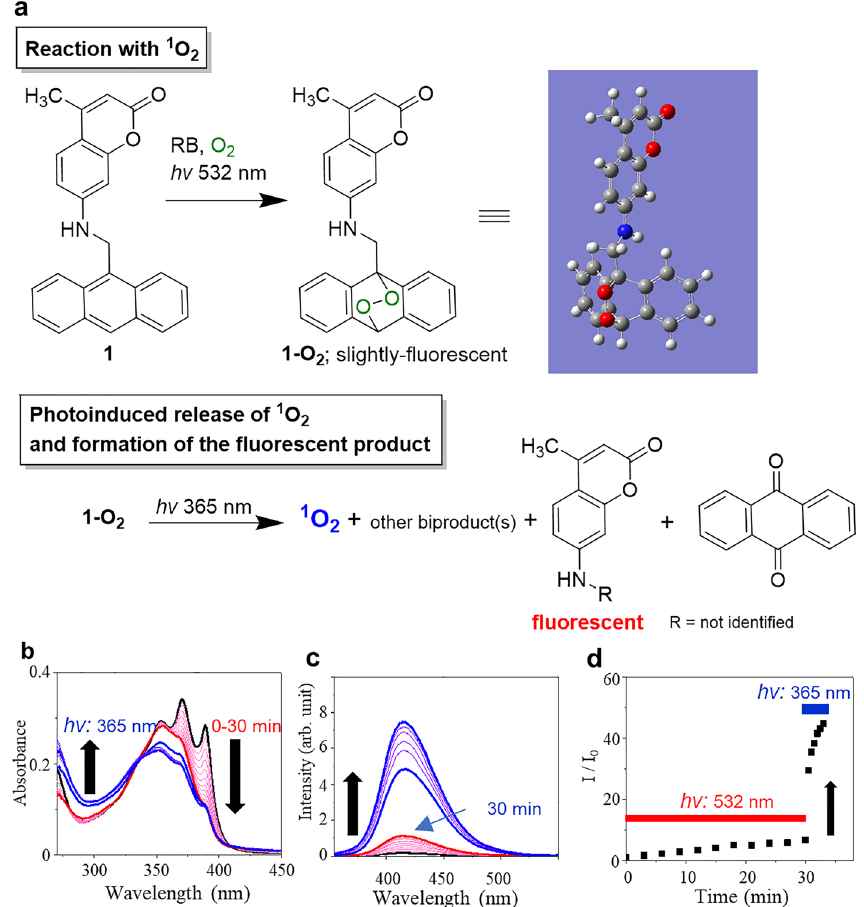
Figure 1. Trapping and photoinduced fluorogenic sensing and release of 1 O 2 . ( a ) Schemes of the two-step reactions of 1 and 1 O 2 . The 3D molecular image shows a DFT-optimized structure. ( b ) Absorption spectra of a solution containing 1 (10 µM) and RB (5.0 µM) in DMF before (black line) and after every 5 min of the photosensitization (red line), followed by photoactivation by UV illumination (365 nm, 1.0 mW cm −2 ) (blue line). ( c ) Fluorescence spectra ( λ ex : 340 nm) of 1 in the same conditions as in ( b ). ( d ) Time-trace of the peak emission intensities at 420 nm in ( c ). The red and blue bars indicate the illumination time points by 532 and 365 nm lights,